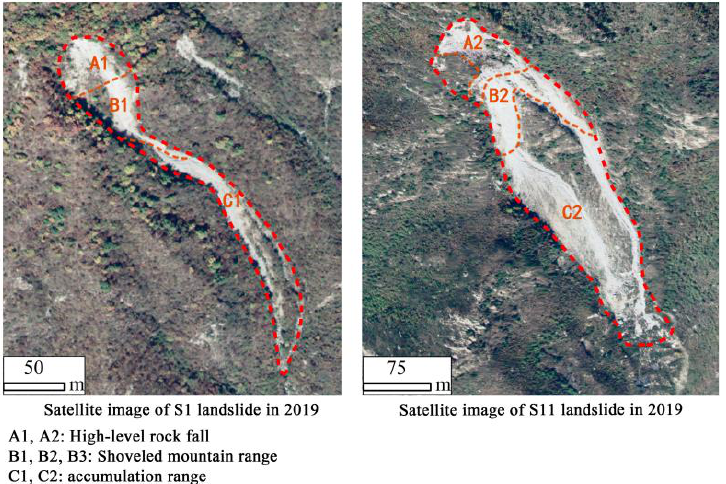
Figure 11. Optical images of landslide S01 ( left ) and S11 ( right ) acquired in 2019. The red dotted line delineates the landslide boundary. A1 and A2 are the rockfall, B1 and B2 are the shoveled mountain range, and C1 and C2 areas are the accumulation range.